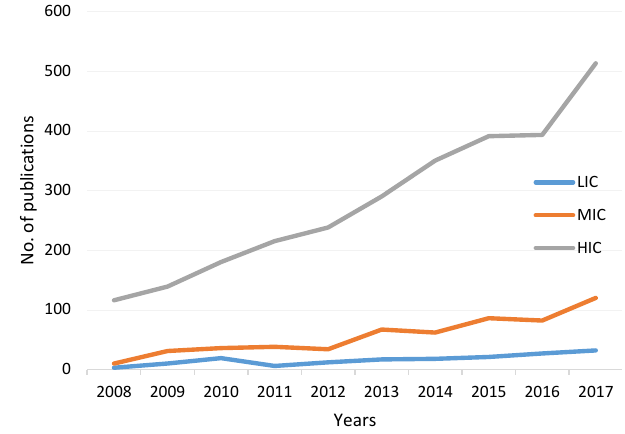
Figure 1. Number of Global Health publications from high-, middle-, and low-income countries.